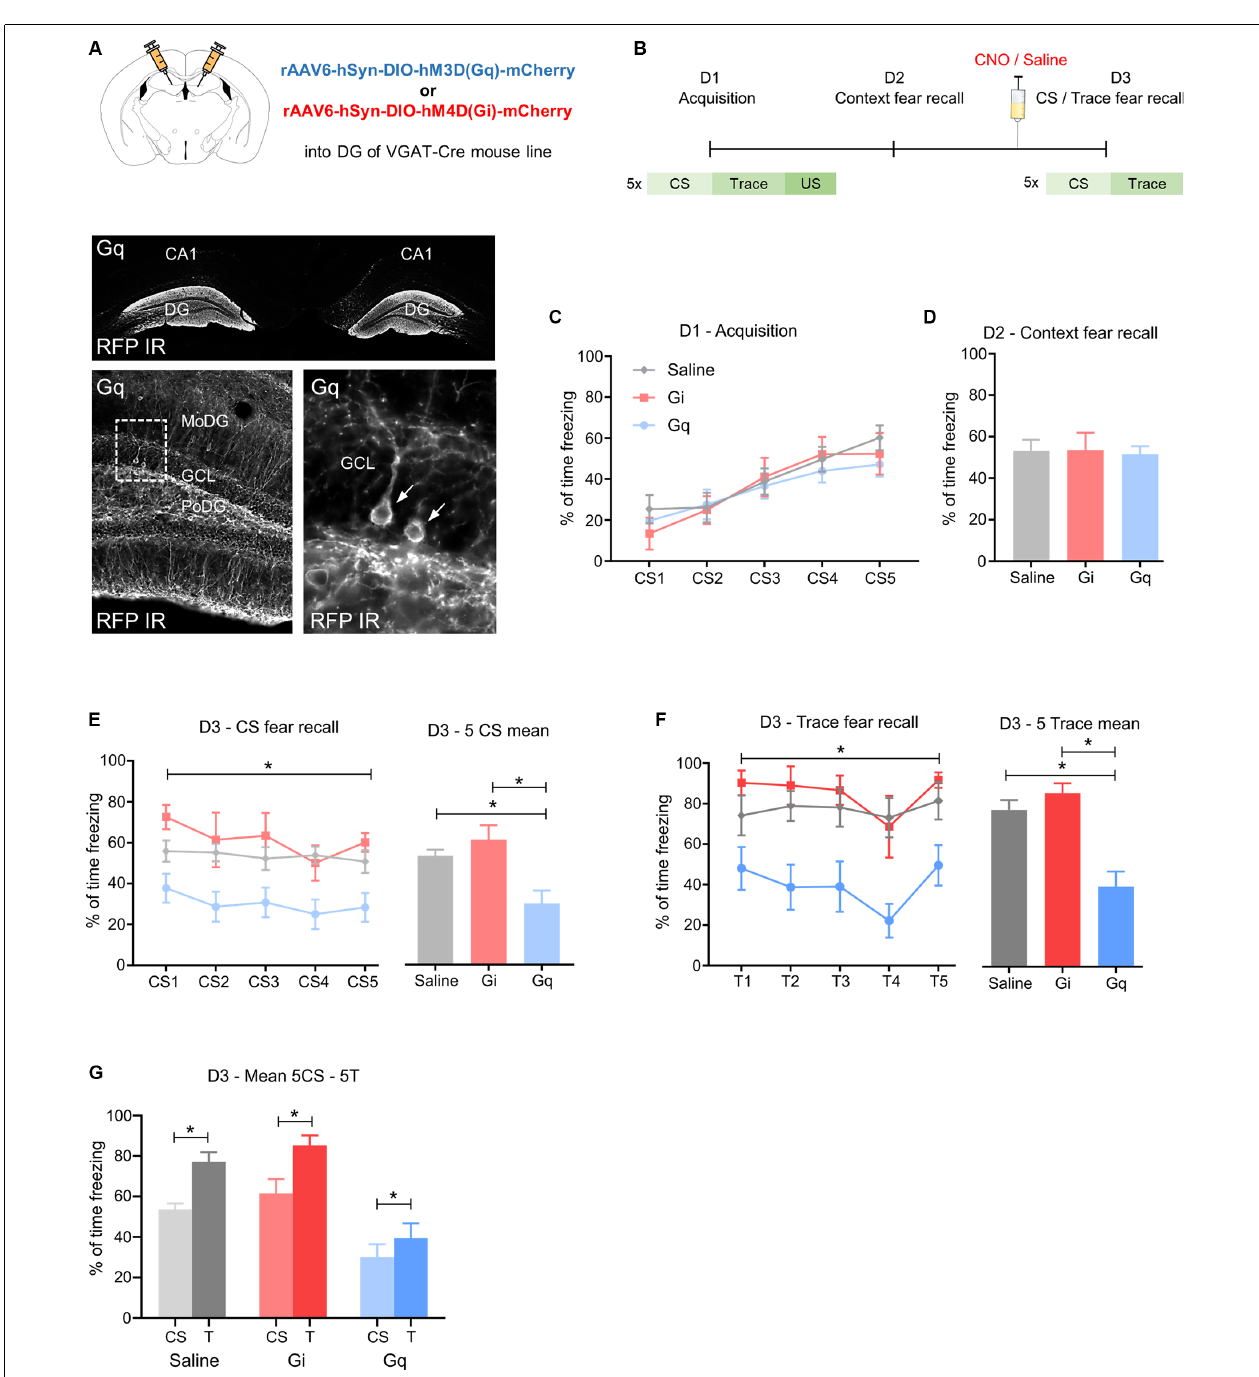
FIGURE 1 | Activation of GABA neurons in the dorsal dentate gyrus reduces fear expression. (A) Upper image: schematic illustration of the injection site of rAAV-hSyn-DIO-hM3DGq-mCherry (Gq) or rAAV-hSyn-DIO-hM4DGi-mCherry (Gi) in the dorsal dentate gyrus (DG) of VGAT-cre mice. Lower image: immunohistochemical distribution of mCherry in the dorsal DG (arrows point towards individual immuno-positive GABA neurons). (B) Schematic fear conditioning protocol. On day 1 (D1), five pairings of a CS (20 s) followed by a 5 s trace and a 0.5 mA footshock were delivered with a variable inter-trial interval of 40–60 s. On day 2 (D2), mice were placed into the acquisition context for 25 min. On day 3 (D3), mice were injected with 1 mg/kg clozapine-N-oxide (CNO) 30 min before fear recall testing, consisting of 5CS presentations in a different context. (C) Equal fear acquisition for all groups, (D) no change in contextual fear, (E) during testing of CS-induced fear recall, Gq group showed a lower percentage of freezing than Gi and saline during 5 CS as demonstrated by two-way ANOVA for repeated measurements and Tukey’s post hoc test. (F) A similar reduction of the percentage of freezing was seen during the trace period. (G) Saline, Gq, and Gi injected mice showed a higher percentage of freezing during the trace period compared to the CS, suggesting intact stimulus contingency. Data are presented as means ± SEM, * P < 0.05. Saline: n = 11, Gi: n = 6, Gq: n = 14. Abbreviation: CS, conditioned stimulus.